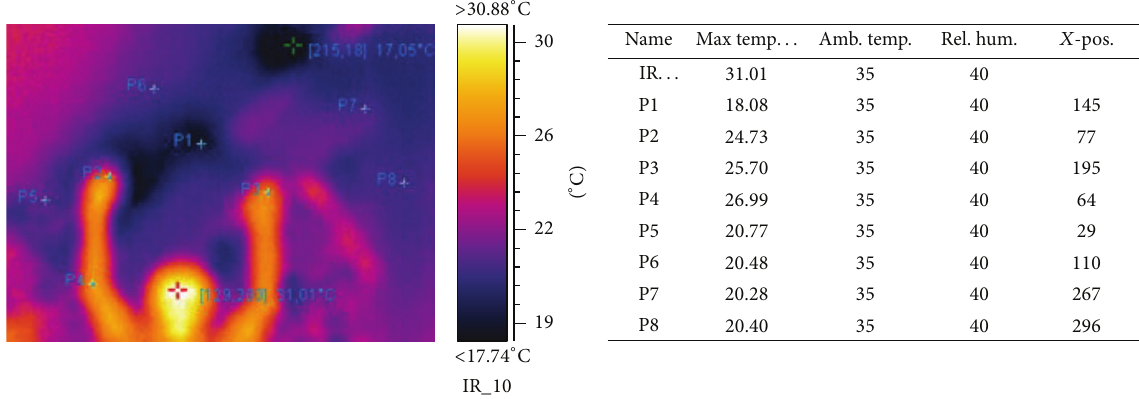
Figure 12: The thermal camera images and information of people raising two